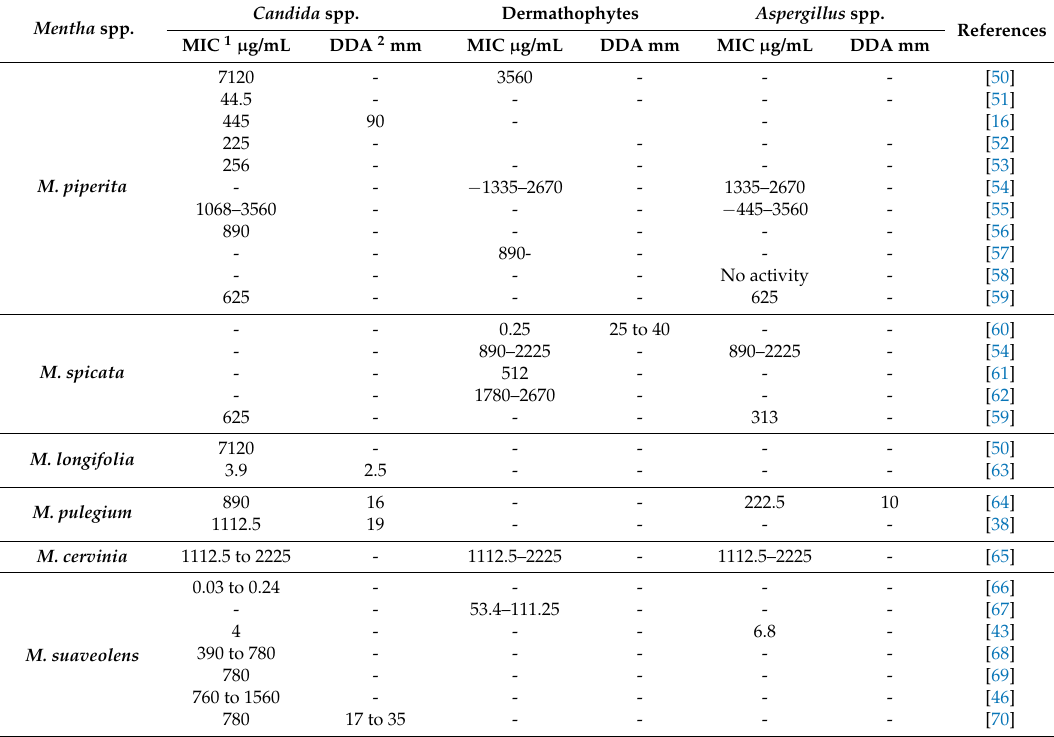
Table 2. Antifungal activity of Mentha spp. EOs against human pathogenic fungi. Mentha